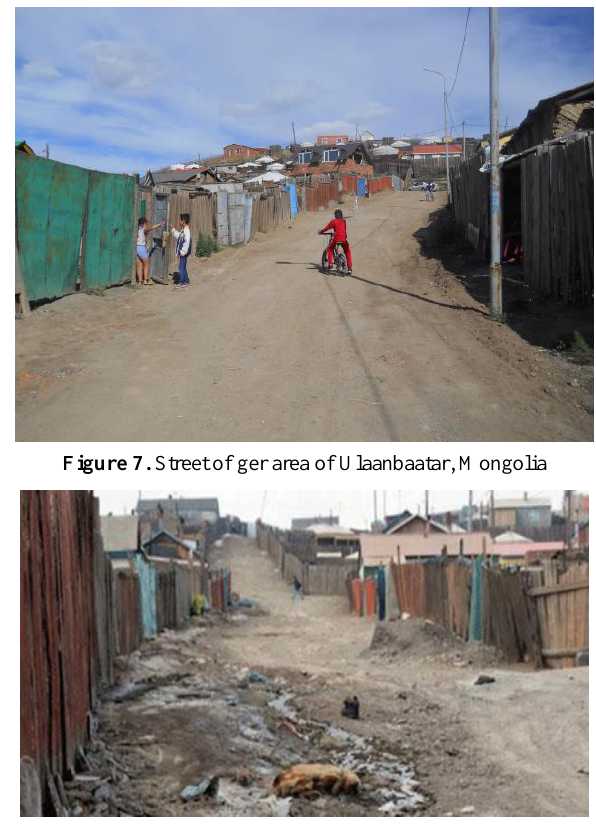
Figure 8. Street of ger area in the